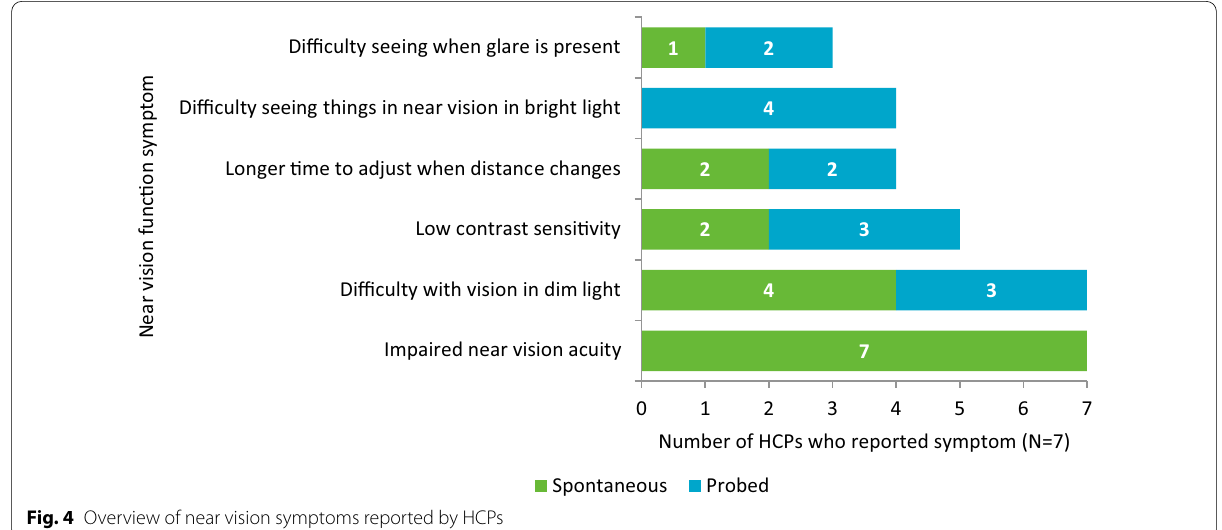
Fig. 4 Overview of near vision symptoms reported by